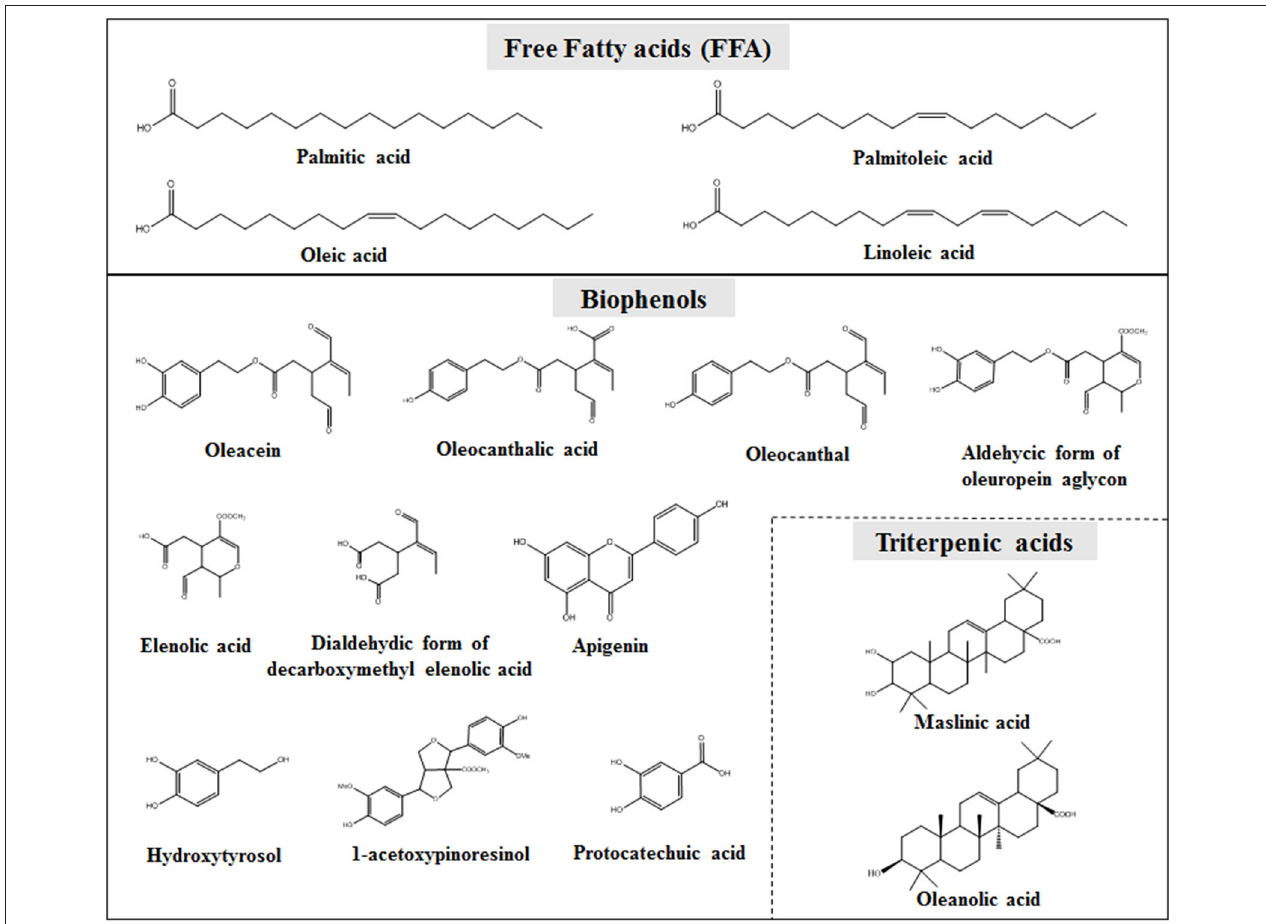
FIGURE 1 | Representative compounds of OO glycerol fraction (upper part) and biophenols fraction (lower part).